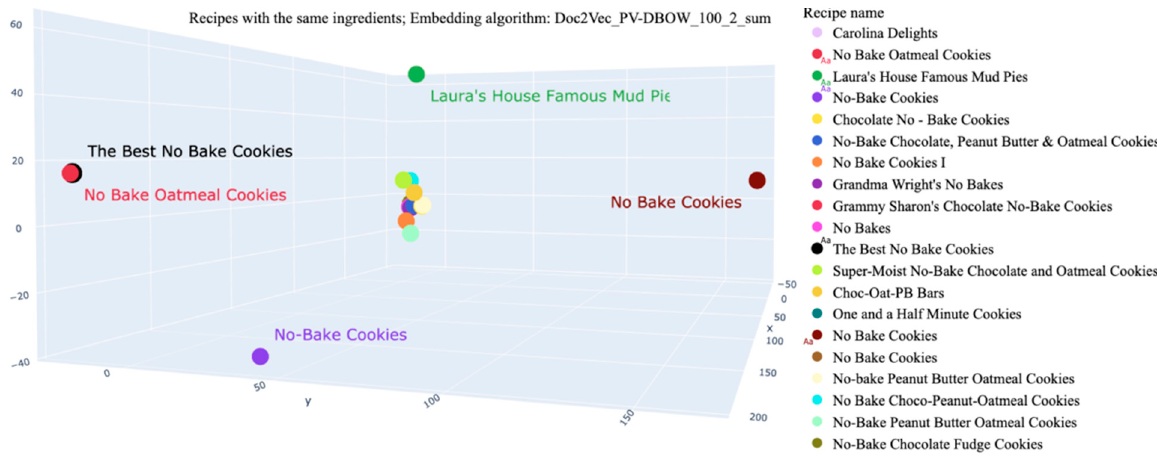
Figure 2. Visual representation of the vector representations when using the domain-specific heuristic of a group of recipes with the same ingredients. Table 3. Nutrient values for recipes with the same ingredient list, but same or different